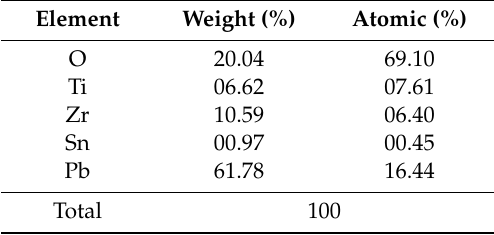
Table 1. Energy dispersive spectrometer (EDS) results of the lead zirconate titanate (PZT) powder.